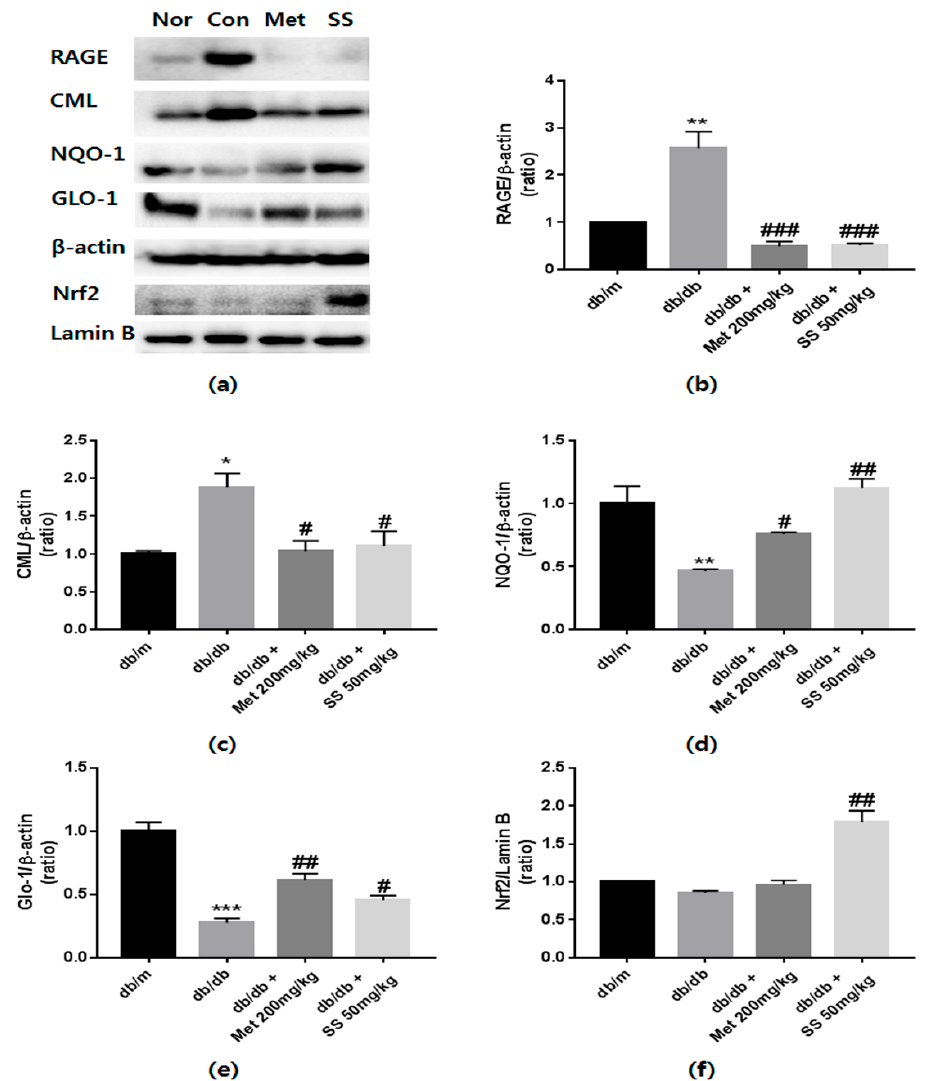
Figure 4. The effects of Spatholobus suberectus extract on the protein levels of receptors of advanced glycation end products (RAGE), N ɛ -(carboxymethyl)-lysine (CML), glyoxalase 1 (Glo1), and nuclear factor, erythroid 2 like 2 (Nrf2). ( a ) Representative western blots bands. β -Actin and lamin-B were used as internal controls. Band intensities of ( b ) RAGE, ( c ) CML, ( d ) NQO1, ( e ) Glo1, and ( f ) Nrf2. MET (Metformin) is used for positive control. Tissue samples were pooled and the experiments were repeated three times. Values are shown as means ± standard error of the mean (SEM); (* p < 0.05, ** p < 0.01 and *** p < 0.001 vs. db/m; # p < 0.05, ## p < 0.01, and ### p < 0.001 vs. db/db).